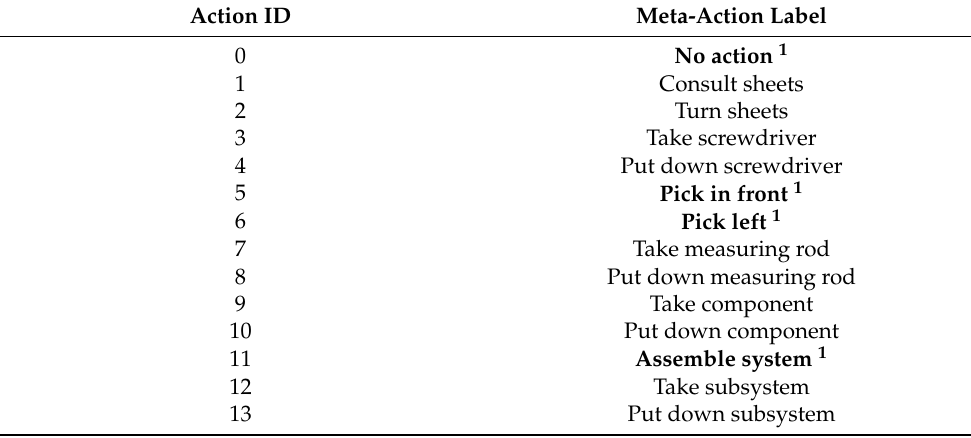
Table 1. InHARD dataset low-level action classes. The highlighted classes are chosen as the action classes of interest.